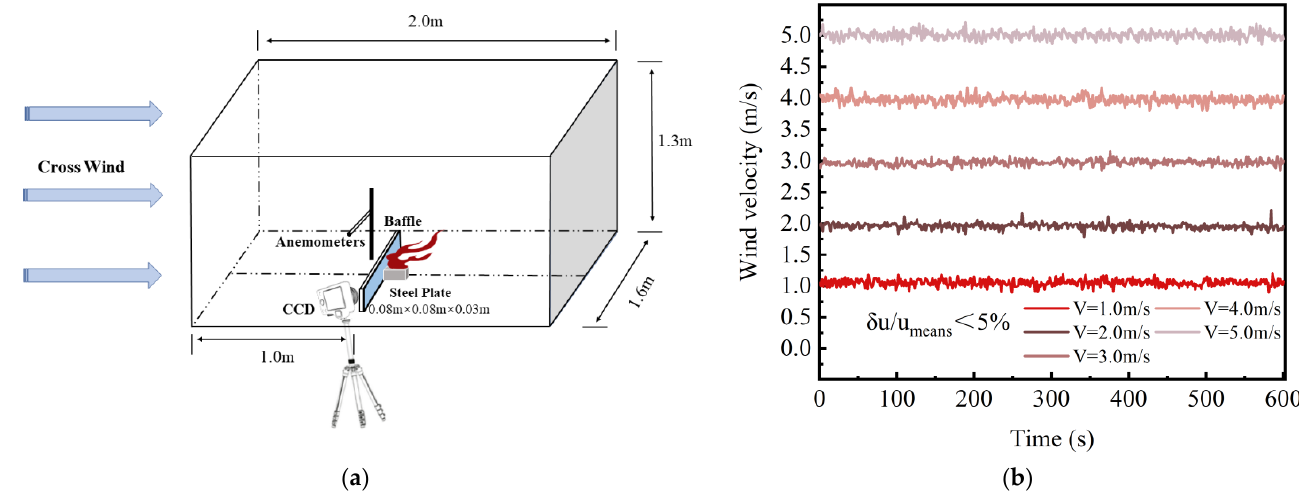
Figure 1. ( a ) Diagram of the experimental section and ( b ) instantaneous horizontal wind speeds. The crosswind speeds in the experiments ranged from 0 to 5 m/s. Before the fire experiments, a hot wire anemometer probe ( ± 0.01 m/s accuracy) was installed 0.1